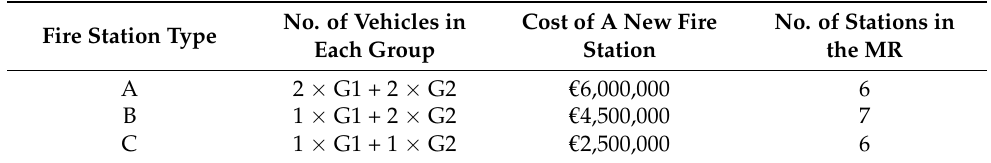
Table 1. Classification of station types in the Madrid Region (MR), costs, and numbers of new fire